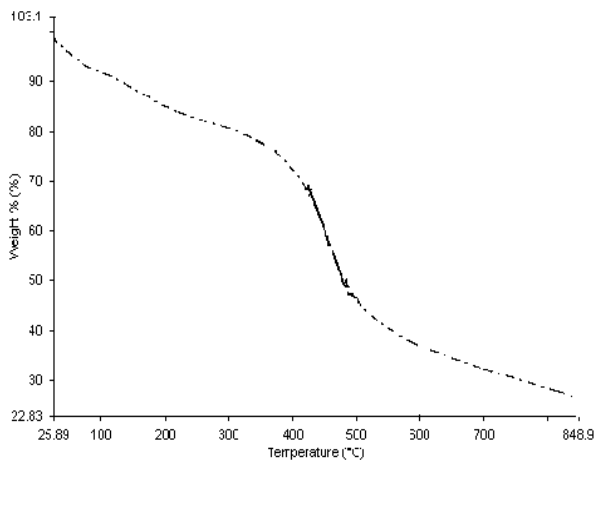
Figure 5: Thermogram of m-CHF-I resin.